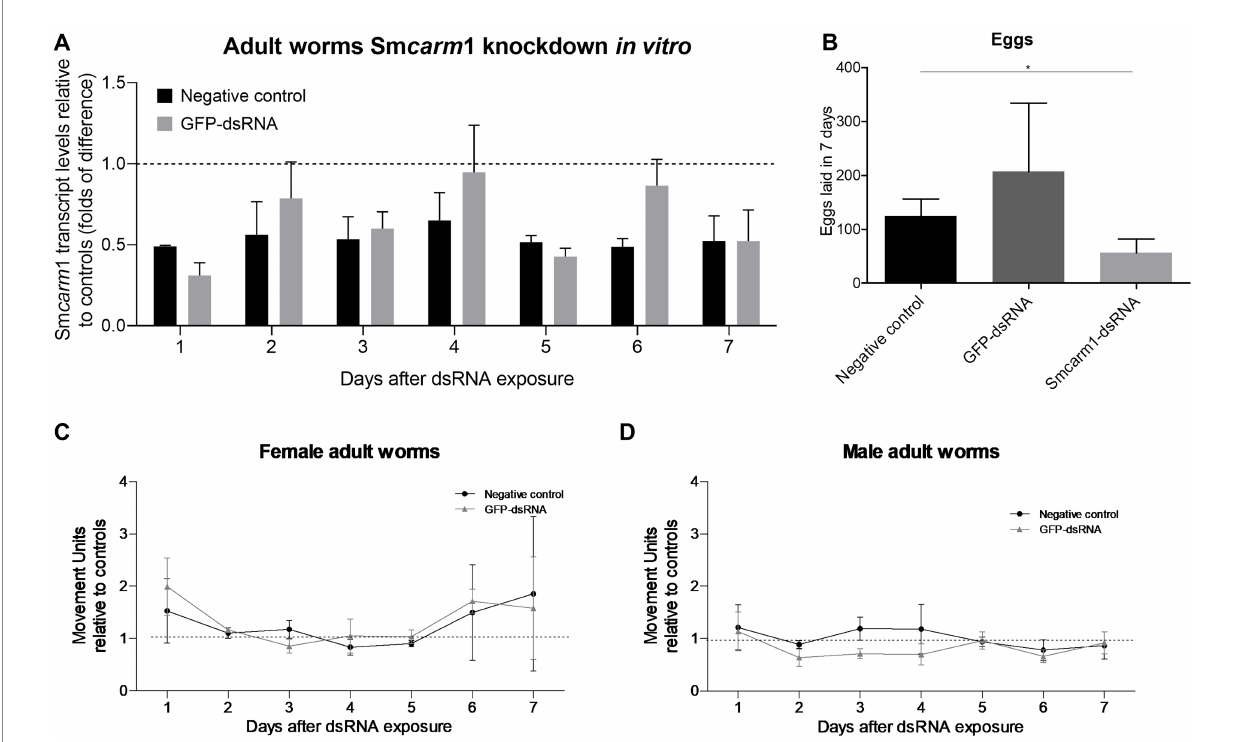
FIGURE 3 Sm carm 1 knockdown in adult worms in vitro . (A) Sm carm 1 transcript levels in adult worms after dsRNA exposure. Bar graph depicting the Sm carm 1 transcript levels in adult worms during 7 days of exposure to Sm carm 1-dsRNA relative to negative (black) or unspecific GFP-dsRNA (gray). Data are represented as mean fold-difference (±SE) relative to controls (dashed line). Mann–Whitney test, N = 4. (B) Bar graph depicting the number of eggs laid during 7 days for adult worms from the negative control (black) and after electroporation with GFP-dsRNA (dark gray) or Sm carm 1-dsRNA (light gray). Paired t -test (* p < 0.05), N = 5. Movement units from (C) female and (D) male adult worms knocked-down for Sm carm 1 normalized with negative (black) or unspecific control (gray). The dotted line represents normalized movement units in the control. Two-way ANOVA, N =